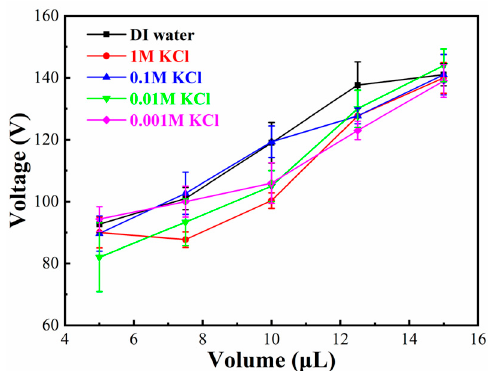
Figure 7. Curves of the relationship between minimum voltage of droplet with different materials and different volumes of droplet.